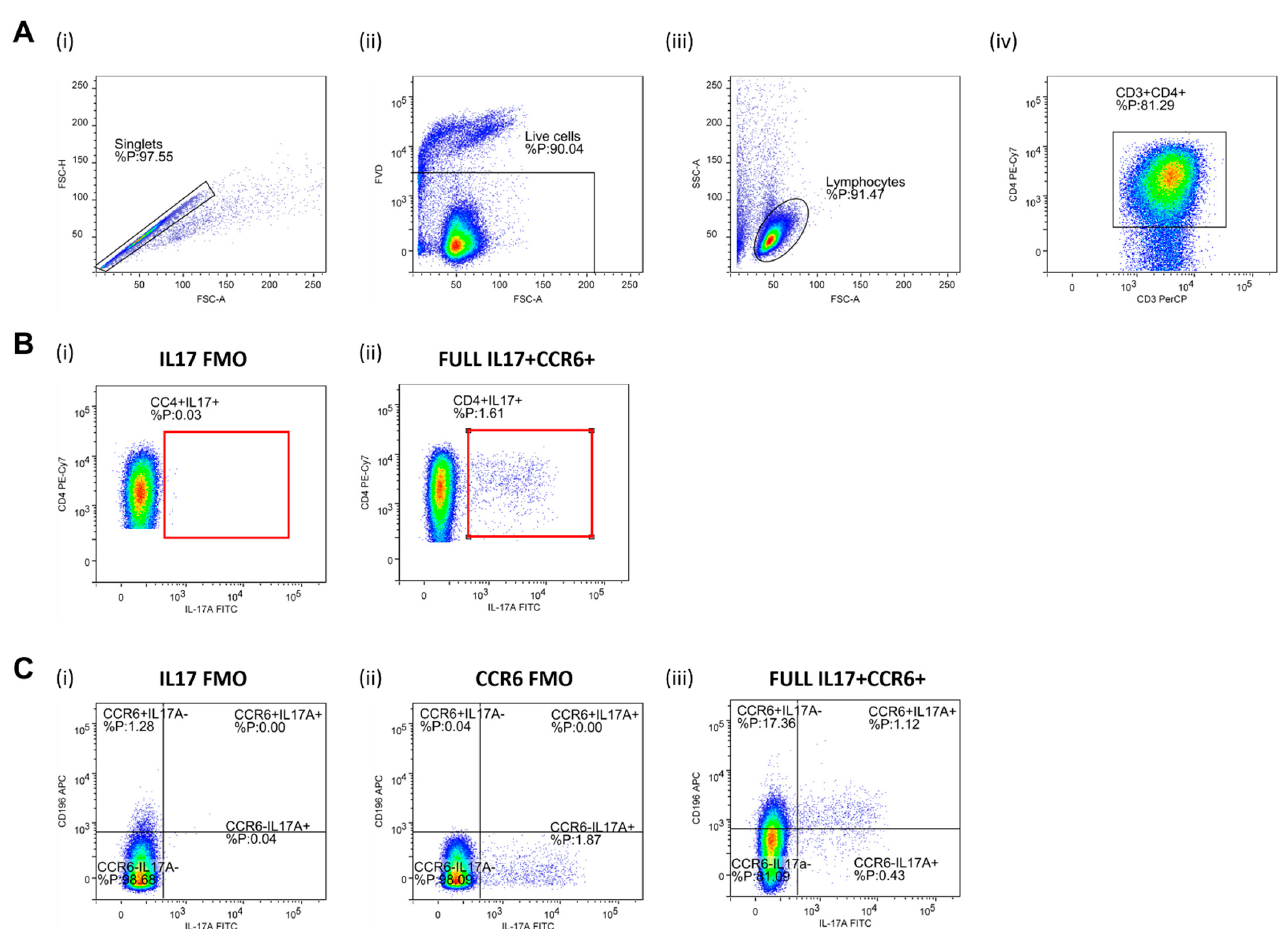
Figure 2. Gating strategy for the assessment of peripheral blood Th17 population by flow cytometry. Panel ( A ) shows representative dot plots illustrating gating strategy, including exclusion of doublets using forward scatter area (FSC ‐ A) versus forward scatter width (FSC ‐ W) analysis ( A ‐ i ), gating on live cells negative for amine ‐ reactive fixable viability dye ( A ‐ ii ), lymphocytes ( A ‐ iii ), CD3 + T cells ( A ‐ iv ), and CD3 + CD4 + T helper cells ( A ‐ iv ). T helper cells were subsequently analyzed for IL ‐ 17A and CD196/CCR6 expression. First, total IL ‐ 17 ‐ secreting T helper cells were analyzed (Panel ( B )) where the gate on IL ‐ 17 + T cells were defined using florescence minus one (FMO) control for IL17 antibody ( B ‐ i ). A representative sample demonstrating relative frequencies of peripheral CD4 + IL ‐ 17 + T helper cells in healthy young individuals are shown at ( B ‐ ii ). The population of IL ‐ 17 ‐ secreting T helper cells was further analyzed for CD196/CCR6 expression (panel ( C ), C ‐ iii ), hence two sub ‐ populations were identified—CD4 + CD196 + IL17 + corresponding to Th17 cells and CD4 + CD196 ‐ IL17 + non ‐ Th17 cells accounting for other T helper subpopulations with the capacity to secrete IL ‐ 17. FMO gates ( C ‐ i , C ‐ ii ). FlowLogic software was used for data analysis and illustration.